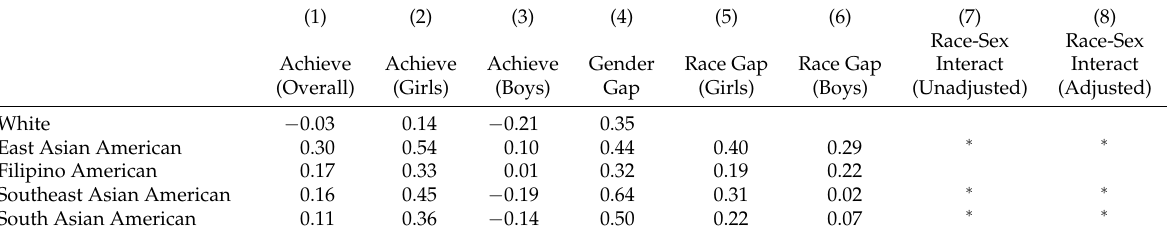
Table 4: Predicted achievement scores by gender and Asian ethnic subgroups, 11th-grade